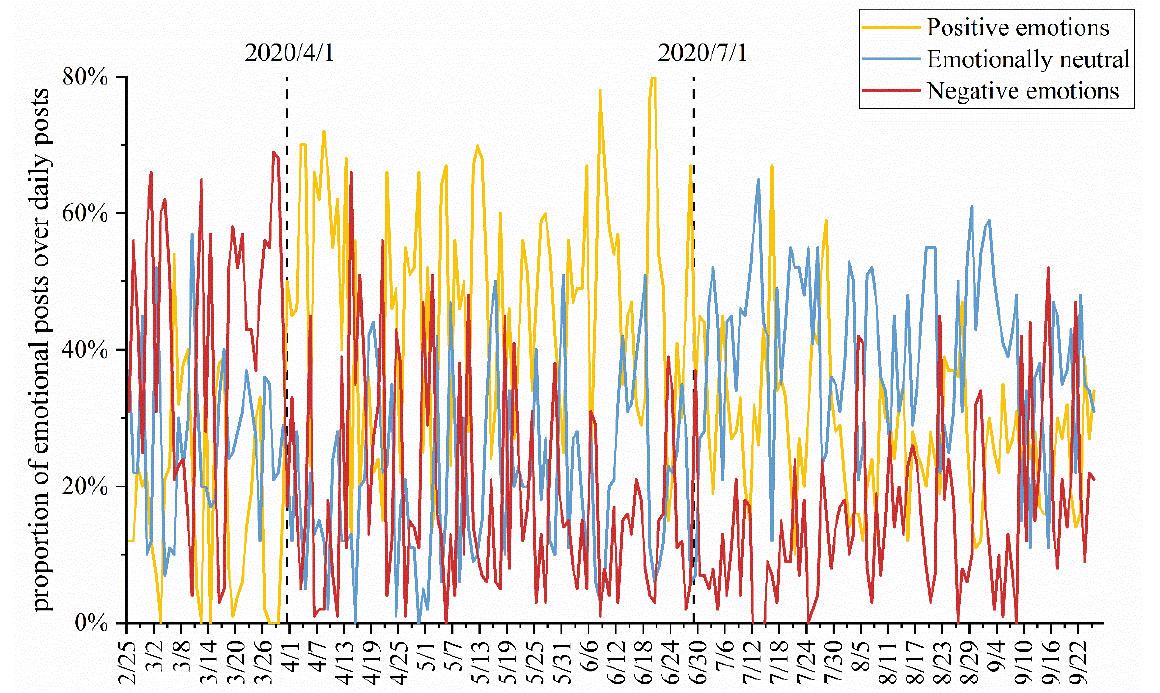
Figure 6. Proportion of emotional posts over daily posts.